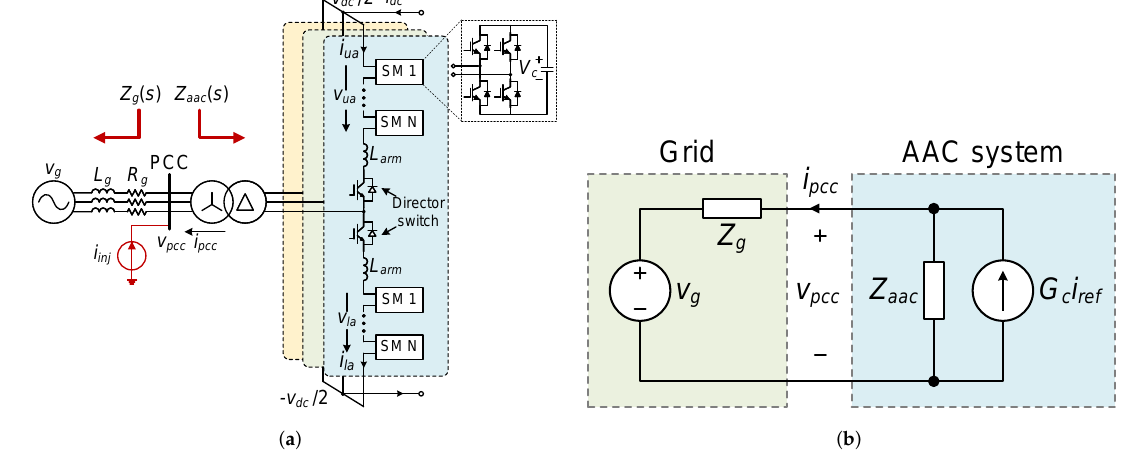
Figure 1. Configuration and equivalent model of a grid-tied current controlled AAC system: ( a ) basic structure; ( b ) equivalent model.